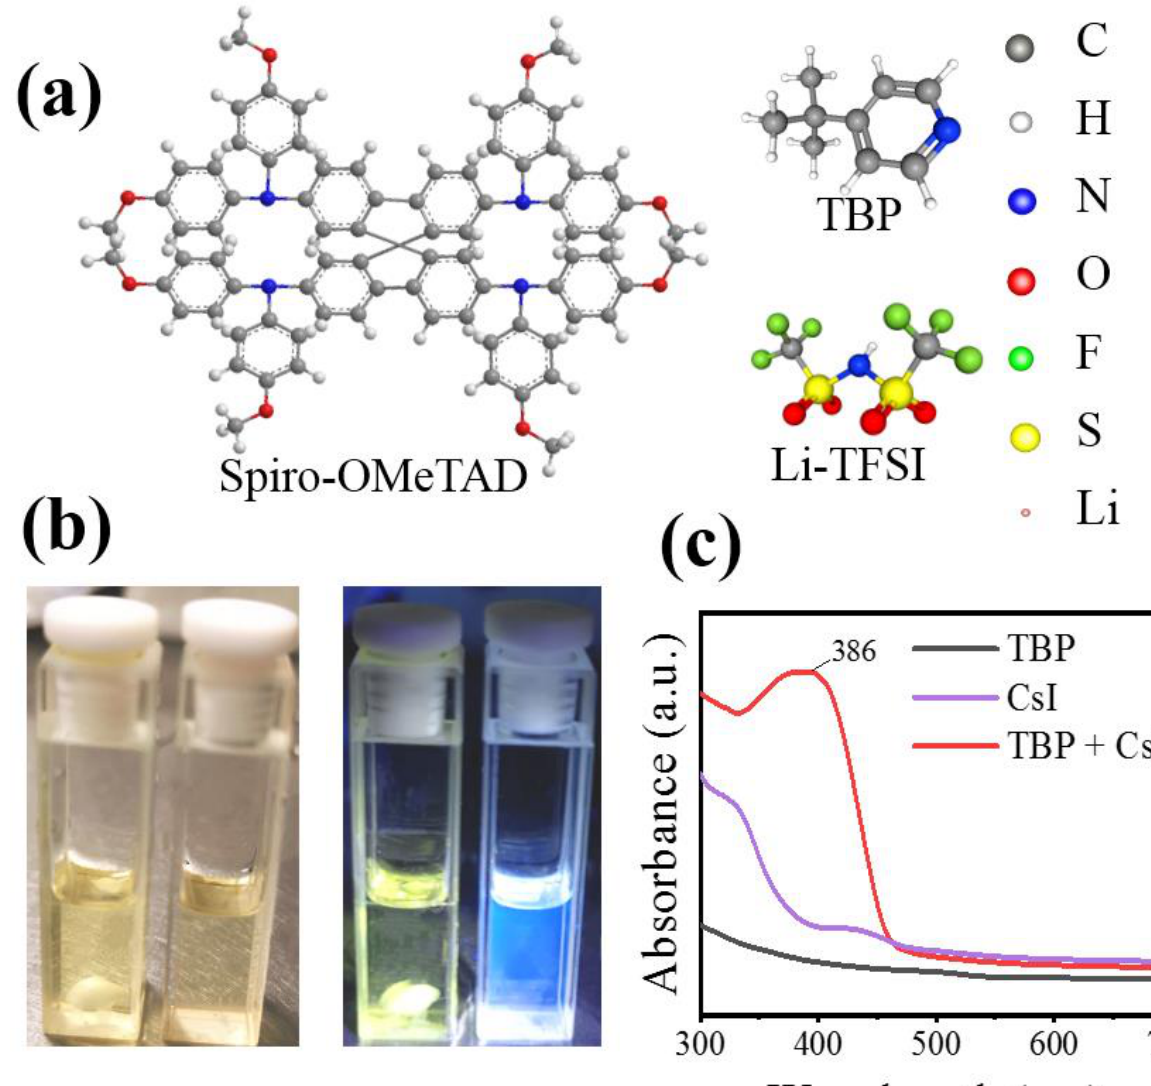
Figure 4. ( a ) Molecular structures of Spiro-OMeTAD, Li-TFSI, and TBP. ( b ) Optical image of TBP and CsI dissolved in TBP under white light (left) and ultraviolet light (right). ( c ) UV-visible absorption spectra of CsI, TBP, and CsI dissolved in TBP.